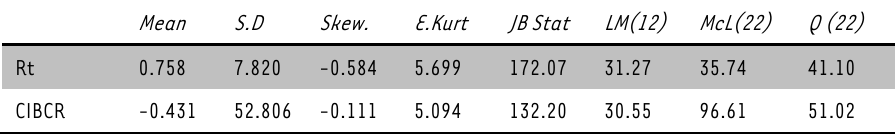
TABLE 1: Descriptive Statistics and Test for ARCH Effect